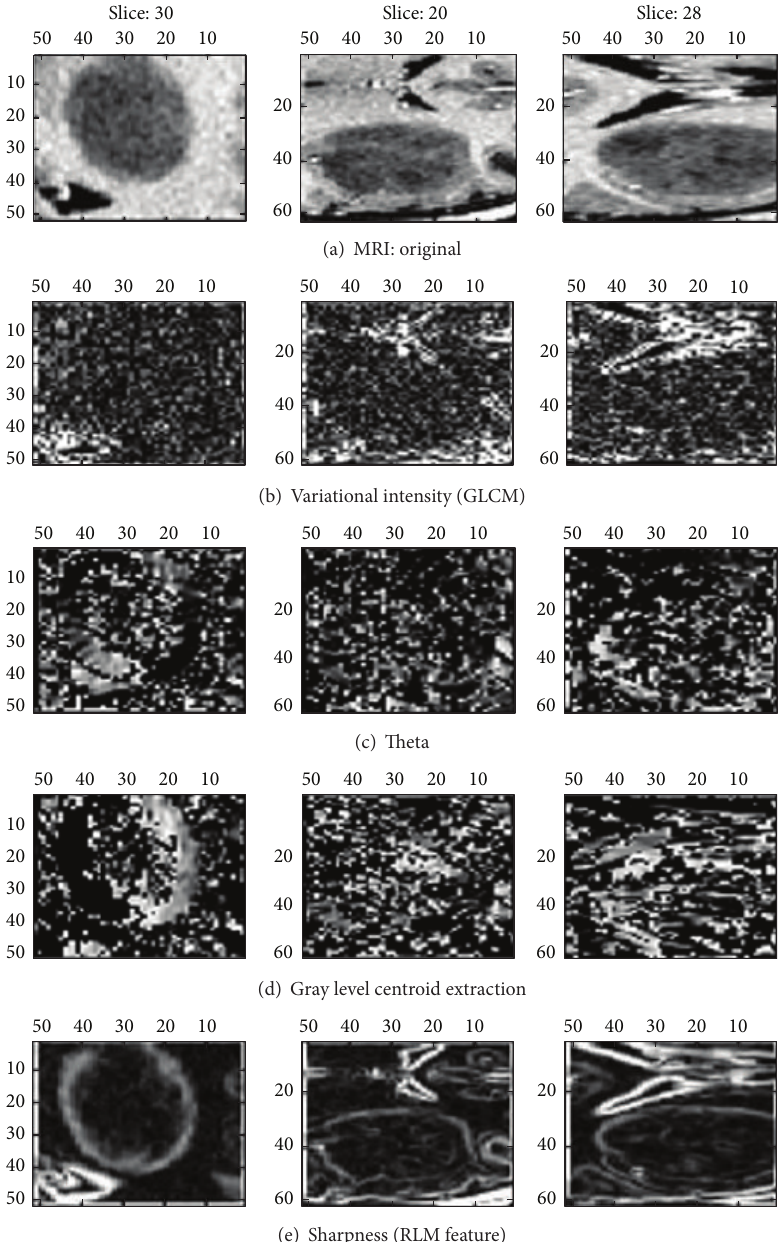
Figure 7: Features extracted from the integrated 3D approach.